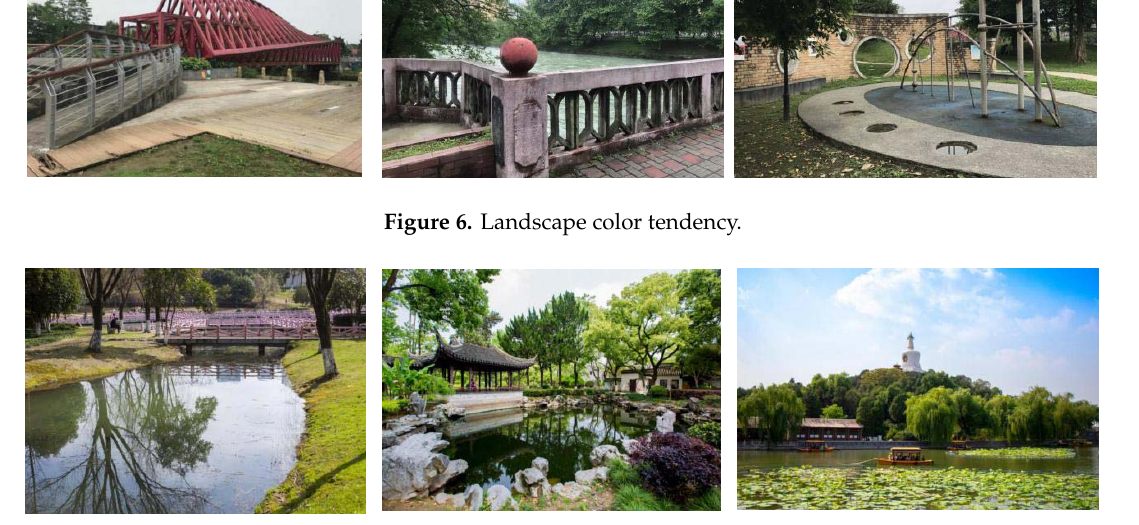
Figure 7. Network landscape trend color map.